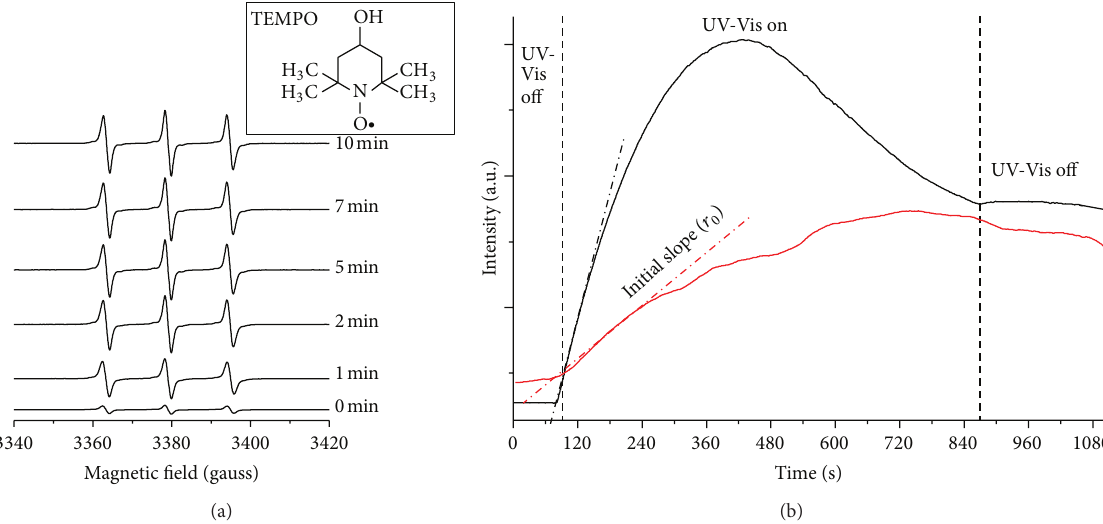
Figure 10: (a) Variation of resonance lines of the TEMPO radical (structure shown in the inset), with the UV-Vis irradiation time for the TS aqueous suspension; (b) time course of the TEMPO signal maximum before and during UV-Vis irradiation for TiO 2 (black line) and TS (red line) samples. The initial slope ( 𝑟 𝑜 ) of the curve was taken as representative parameter to evaluate the initial rate of 1 O 2